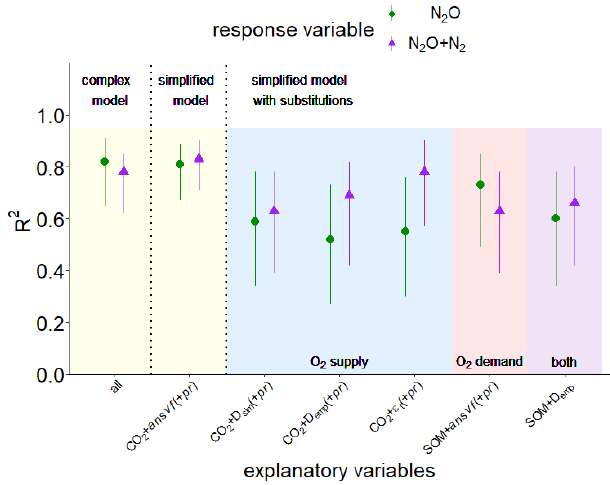
Figure 8. Conceptual scheme of oxygen (O 2 ) supply and demand and its effect on denitrification. Material classes include soil matrix (grey area), water (blue), mineral grains (light grey), connected air (red), and isolated air (rose). The black line divides between aero- bic (light-grey area) and anaerobic (dark-grey area) conditions. O 2 supply and demand regulate the formation of anaerobic soil vol- ume fraction (ansvf) as an imprint of the spatial distribution of con- nected air (item number 1), respiration (item number 2) that would move the boundary between oxic and anoxic zones in the soil ma- trix closer towards the pore when soil respiration is high (and vice versa), and N 2 O reduction to N 2 (expressed by the product ratio (pr); item number 3). The numbered items show how the explana- tory variables that best describe N 2 O release affect